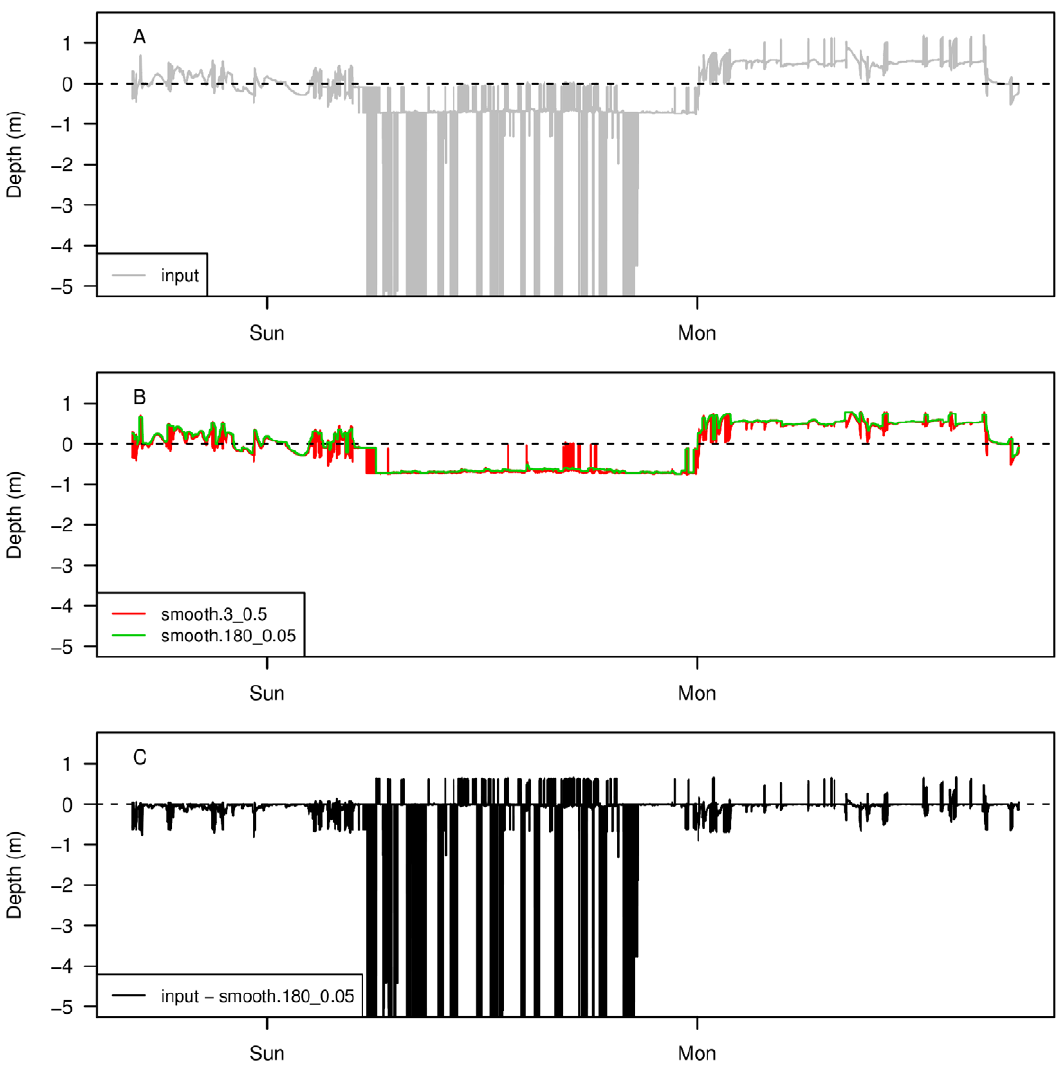
Figure 5. Zero offset correction of TDR data from a Cassin’s auklet. Input time series (A), first filter (median) using a moving window of size 3 (9 s) and second filter (0.05 quantile) using moving window of size 180 (9 min) (B), and corrected depth (input series minus last filter) (C). The y-axis limits are restricted to be approximately equal to the range of surface depth in the time series for clarity.